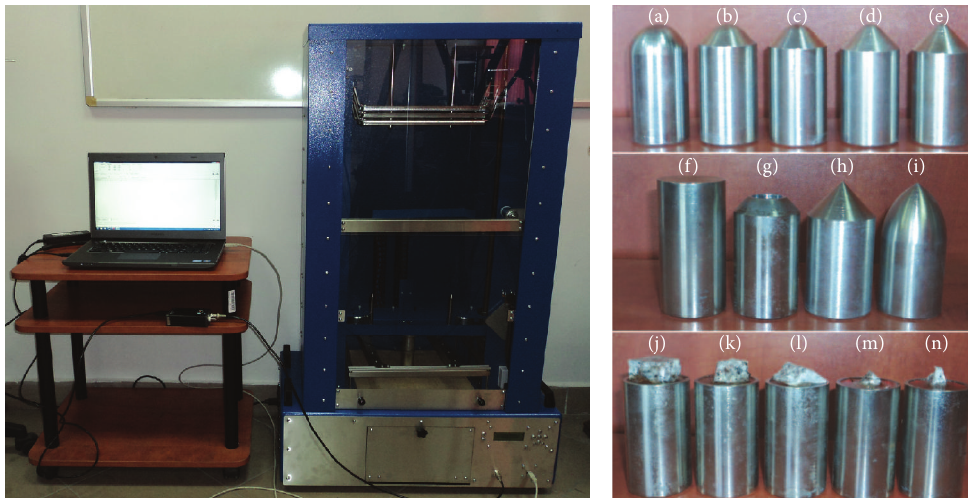
Figure 3: Impactors with rounded ends: (a) R17, (b) R14, (c) R11, (d) R8, and (e) R5mm; impactors: (f) with a flat end ø34 mm, (g) with a flat end ø19mm, (h) with the conic end, and (i) with the arched end; impactors with immersed stones: (j) with flat impact surface, (k) with rough impact surface, (l) edge-ended, (m) vertex-ended, and (n) angle-oriented vertex-ended.